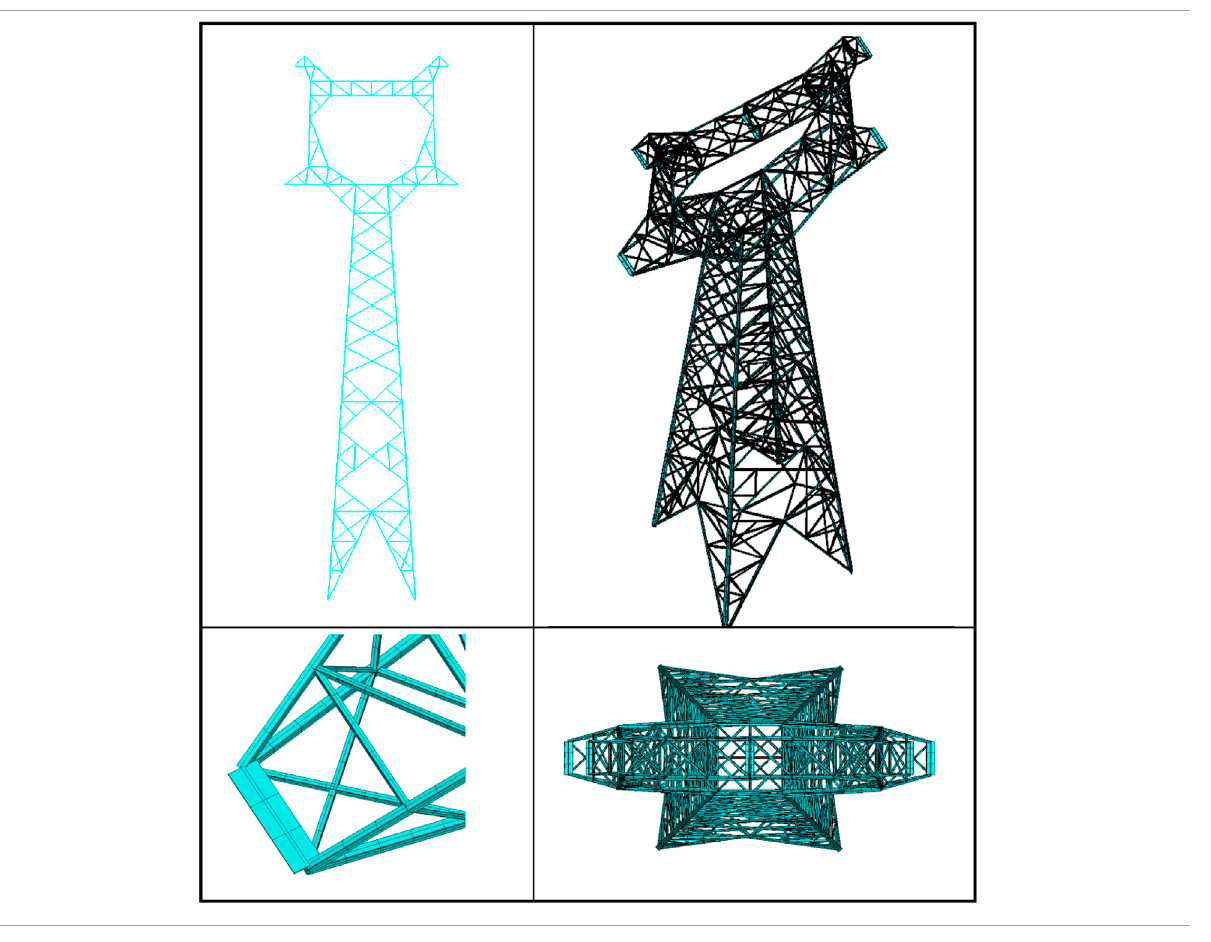
TABLE 1 Grid model.